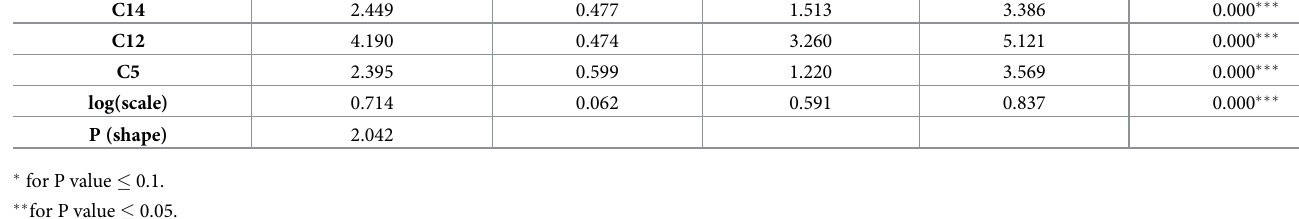
The Weibull AFT model was used to study the influence of each unsafe behavior parameter on the risk of two types of crashes. The results of the sideswipe collision are shown in Table 5 , and the results of the rear-end collision are shown in Table 6 . The estimate for each parameter, standard error (SE), 95% confidence limit, P-value, and shape parameter (P) are obtained from the analysis results. As the two tables shown, for both types of crashes, the shape parame- ter P is greater than 1, which shows that the risk rate increases with time. With the increase in crash duration, the survival probability of the crash decreases, which is consistent with the actual road crash situation.